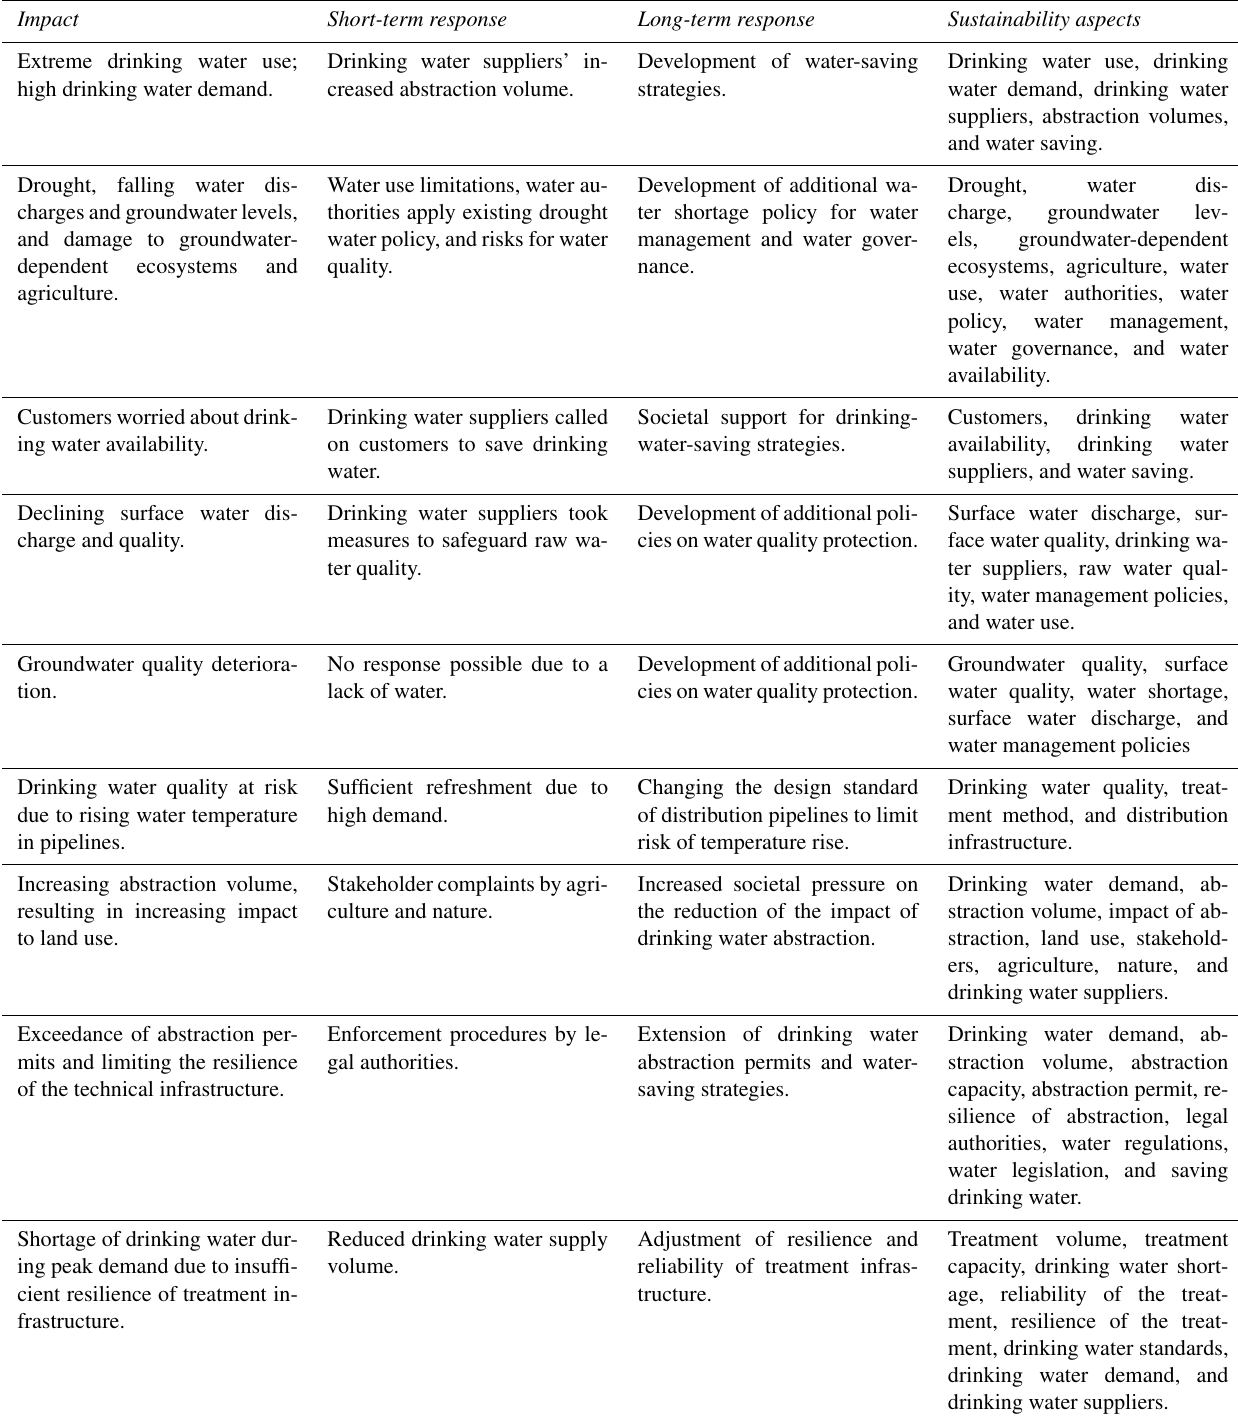
Table A1. Summary of the impact, short- and long-term response, and sustainability aspects in case 1 – 2018 summer drought. In the subsequent Table A2, the full results of the case study are